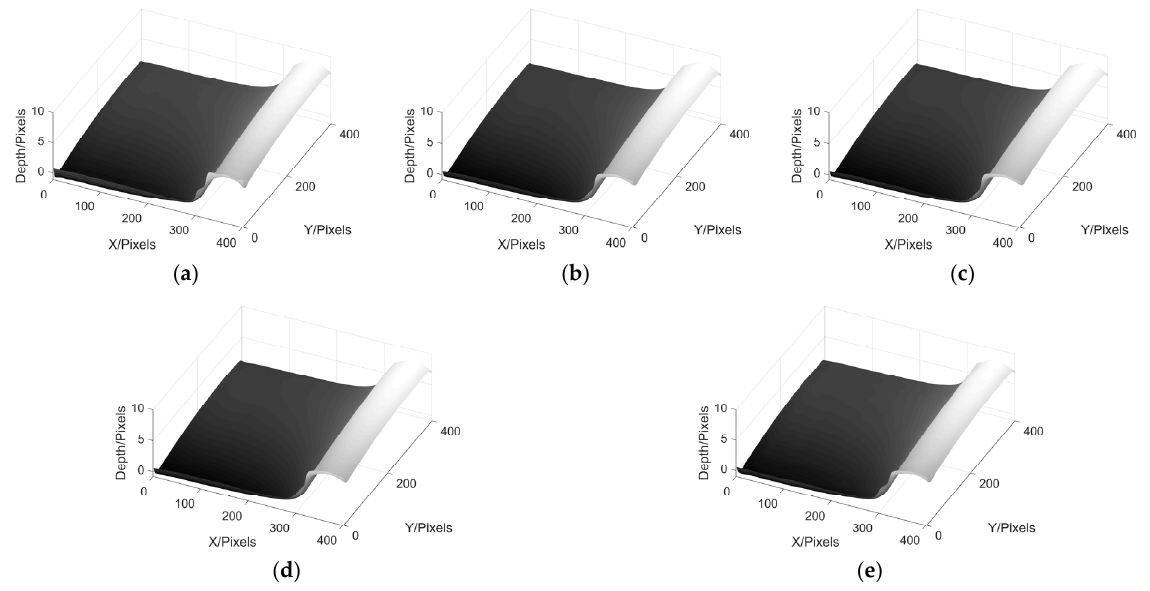
Figure 18. Phase reconstruction results of wheel tread using different filters. ( a ) MP based on Ideal low-pass; ( b ) MP based on Hanning; ( c ) MP based on Blackman; ( d ) MP based on Kaiser; ( e ) MP based on Hilbert transform.